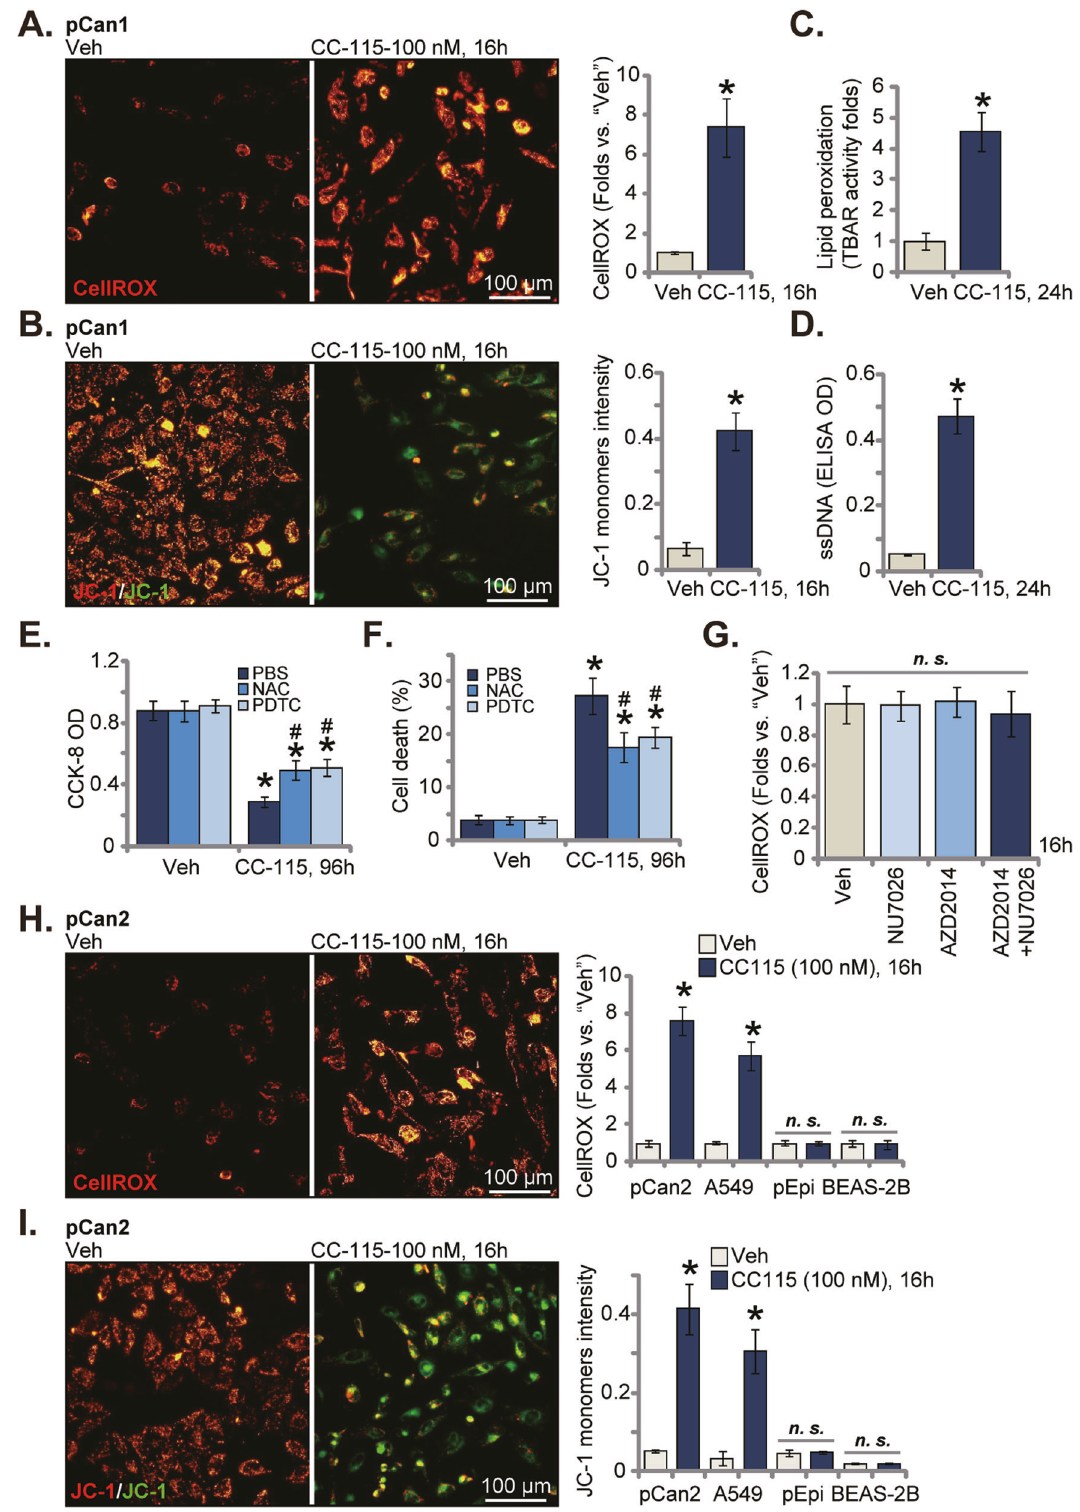
Fig. 5 CC-115 induces ROS production and oxidative injury in NSCLC cells. The pCan1/pCan2 primary human NSCLC cells, the immortalized A549 NSCLC cells, the primary human lung epithelial cells ( “ pEpi ” ) or the BEAS-2B bronchial epithelial cells were treated with CC-115 (100nM), and cultivated for the designated time periods; ROS production, mitochondrial depolarization, lipid peroxidation and DNA breaks were tested by measuring CellROX intensity A , H , JC-1 green monomers intensity B , I , the TBAR activity C and single strand DNA ELISA intensity D , respectively. pCan1 cells were pretreated for 35min with n-acetyl cysteine (NAC, 500 μ M), pyrrolidine dithiocarbamate (PDTC, 10 μ M ) or vehicle control (PBS), followed by CC-115 (100nM, 96h) treatment, cell viability E and death F were examined. pCan1 cells were treated with AZD2014 (100nM), NU7026 (100 nM), or AZD2014 plus NU7026, cells were further cultivated for 16 h; ROS intensity was tested by measuring CellROX intensity G . For each assay, n = 5. * P <0.05 versus “ Veh ” group. # P <0.05 versus “ PBS ” group E , F . “ n.s . ” stands for non-statistical difference. Scale bar = 100 μ m A , B , H , and I . Cell Death Discovery (2022)